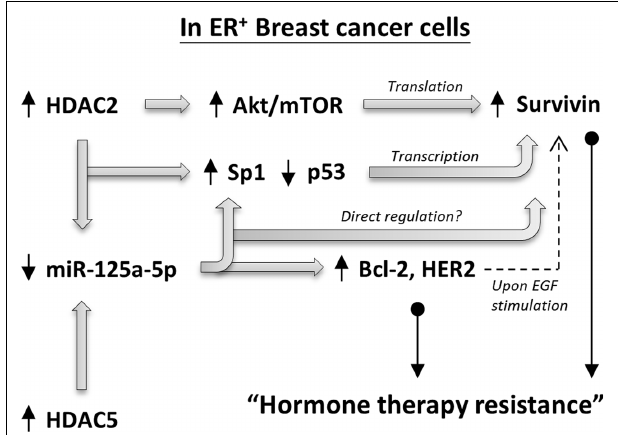
FIGURE 7 | Schematic diagram showing the HDAC2/HDAC5 regulating molecular network in ER + breast cancer